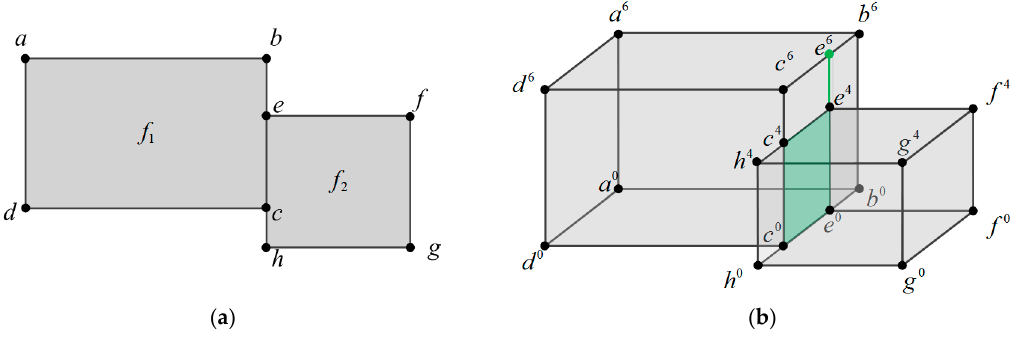
Figure 12. Non-overlapping footprints ( a ) and primitives ( b ) that were generated by extruding footprints in ( a ), which contain redundancies.